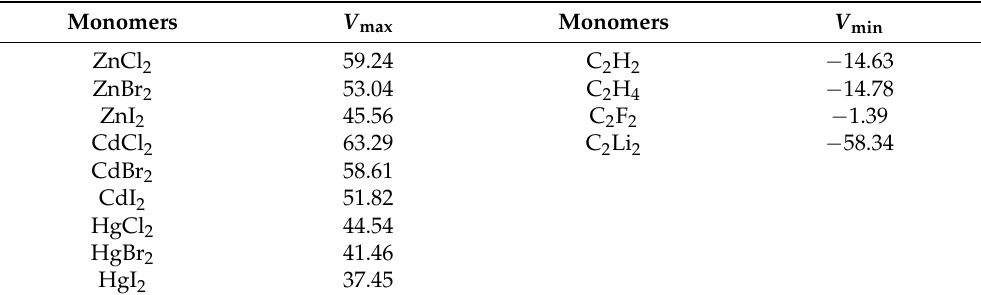
Table 1. The most positive ( V max ) and negative ( V min ) MEPs on the M atoms and π systems. All in kcal/mol.